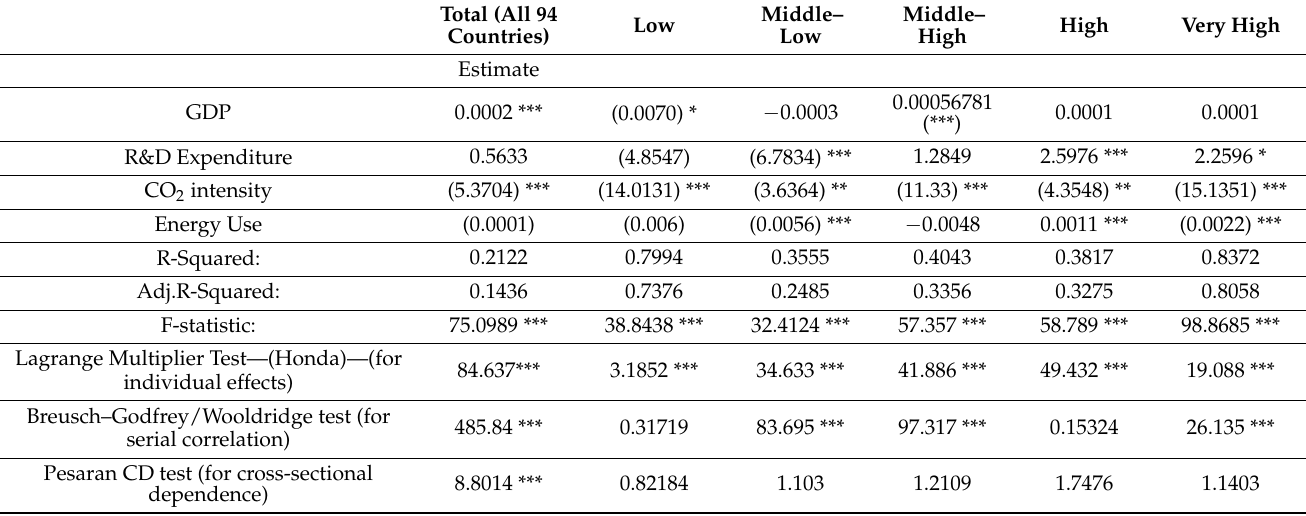
Table 3. One-way country fixed effects (CFEM) with standard errors panel model results. Total (All 94